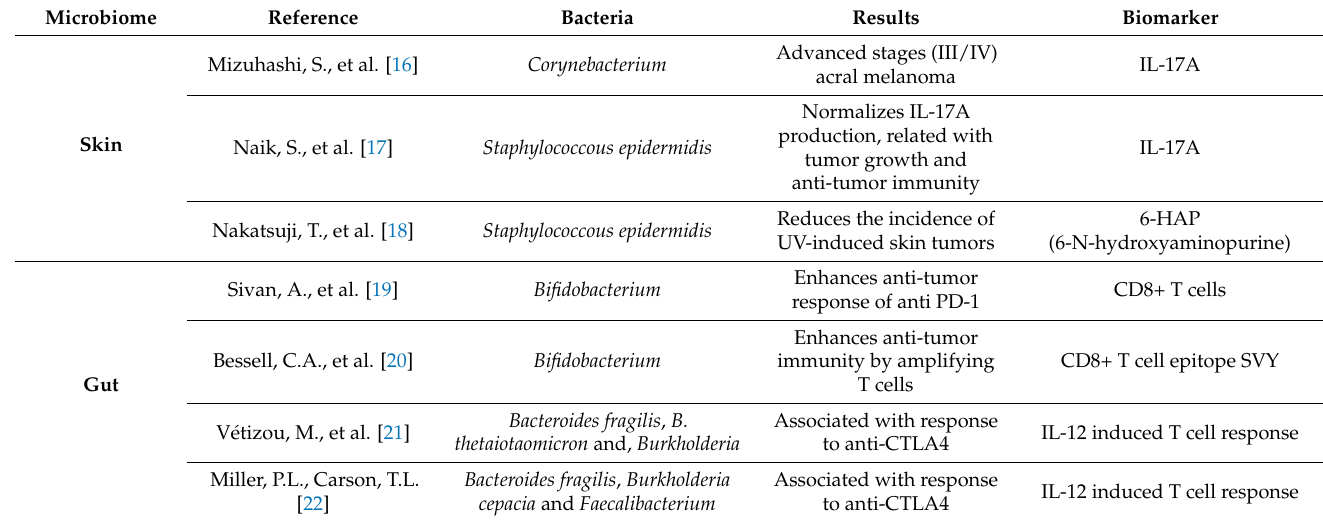
Table 1. Evidence of the impact of skin and gut microbiome in cancer and response to treatment, and associated biomarkers. PFS: progression-free survival, OS: overall